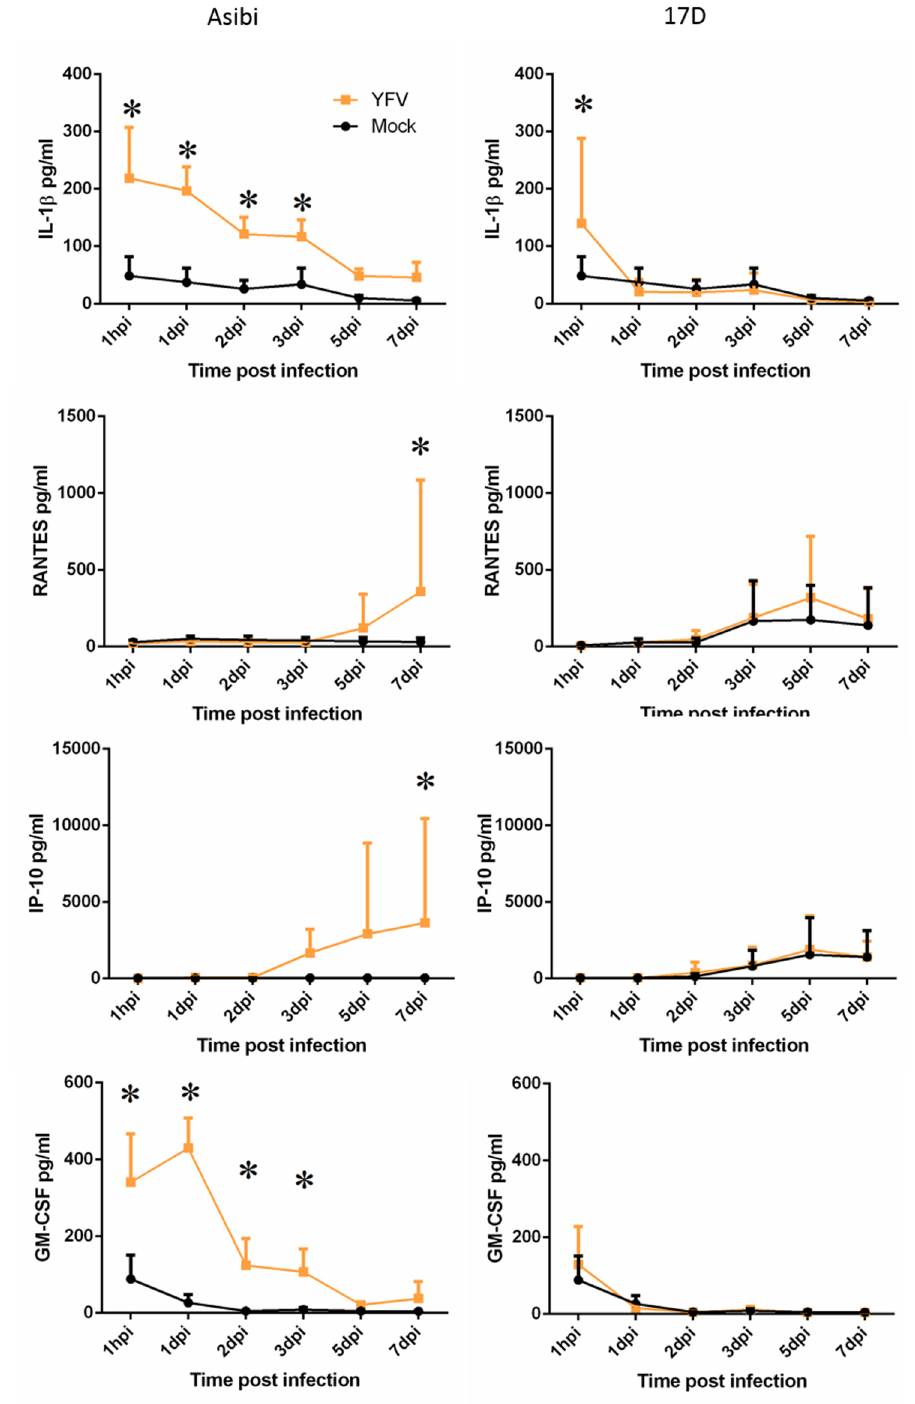
Fig 5. Cytokine and chemokine response in human MoDC. Cytokine and chemokine response in human MoDC infected with either wild-type Asibi virus or the vaccine strain 17D virus (yellow) in relation to mock (black) infected cells. ( * ) indicates points of significant (p < 0.05) difference between virus and mock infected cells. Repeated measures ANOVA run in SAS was used to determine statistical